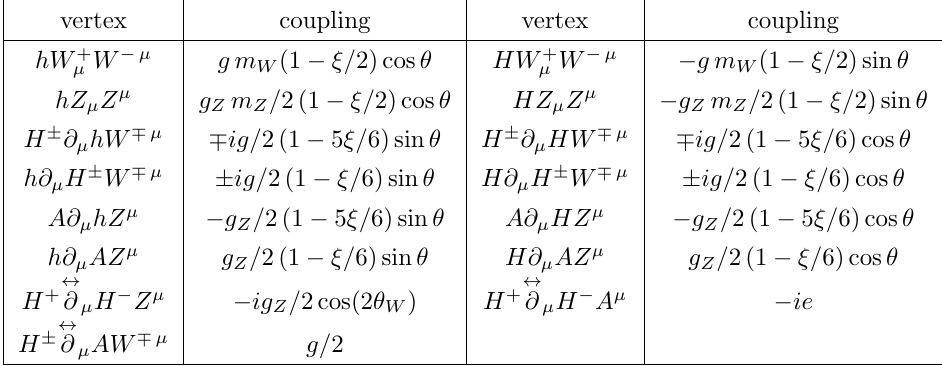
Table 1 . Trilinear couplings between (pseudo)scalars and SM gauge